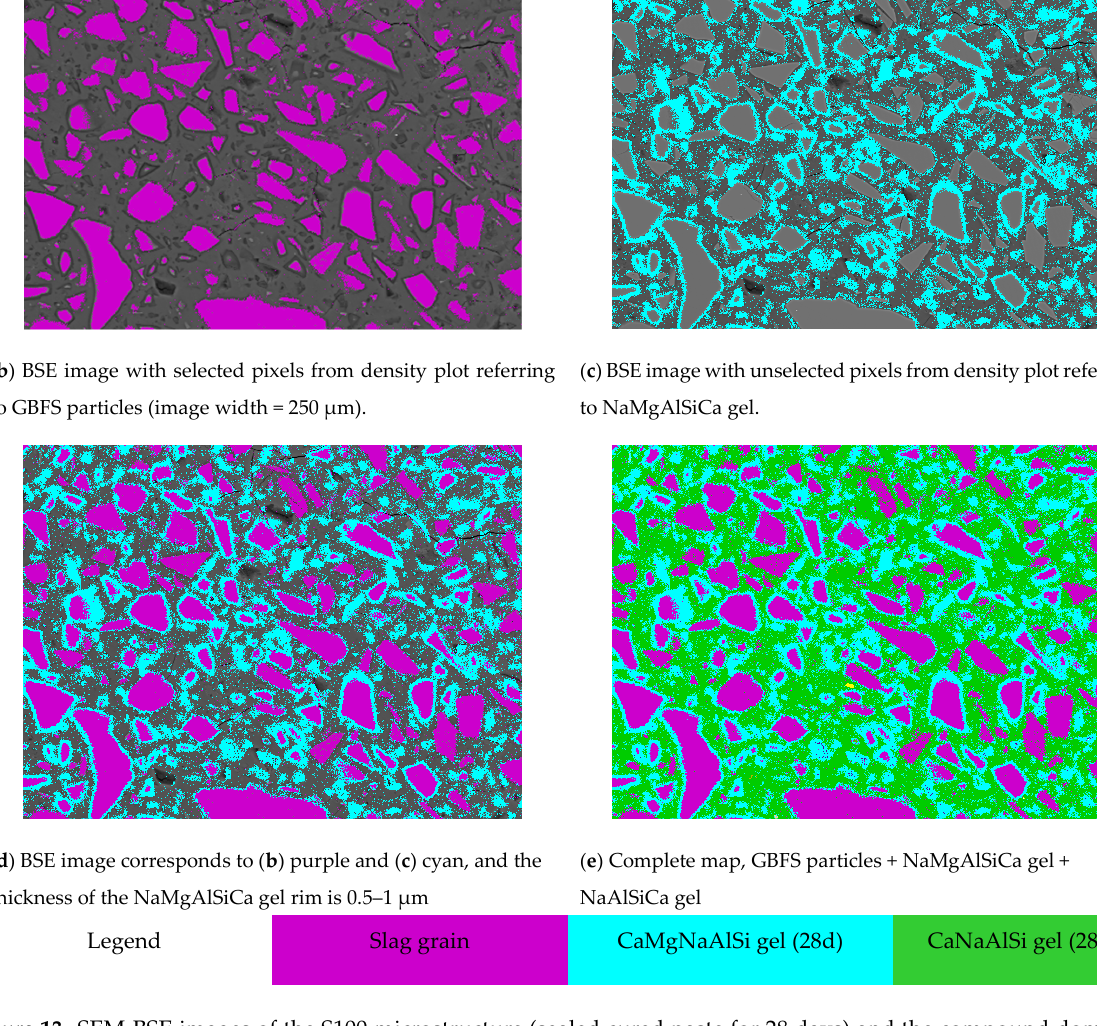
Figure 13. SEM-BSE images of the S100 microstructure (sealed cured paste for 28 days) and the compound domains of different